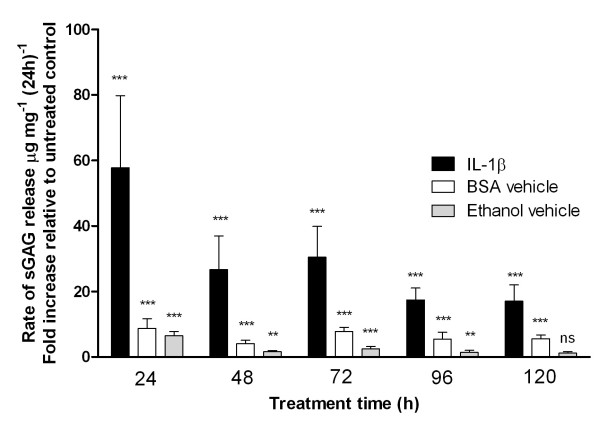
The vehicles bovine serum albumin (BSA) and ethanol have a small catabolic effect. Temporal changes in the release of sGAG for cartilage explants treated with either BSA or ethanol. Data are normalised to that for untreated control explants and presented as a fold increase with median values and error bars showing interquartile ranges. Data are grouped together for all ethanol doses (0.08-8 μM) as no statistically significant dose-response relationship was found. Statistically significant differences from untreated controls are indicated on the basis of Mann-Whitney U tests (*P < 0.05, **P < 0.01, ***P < 0.001).